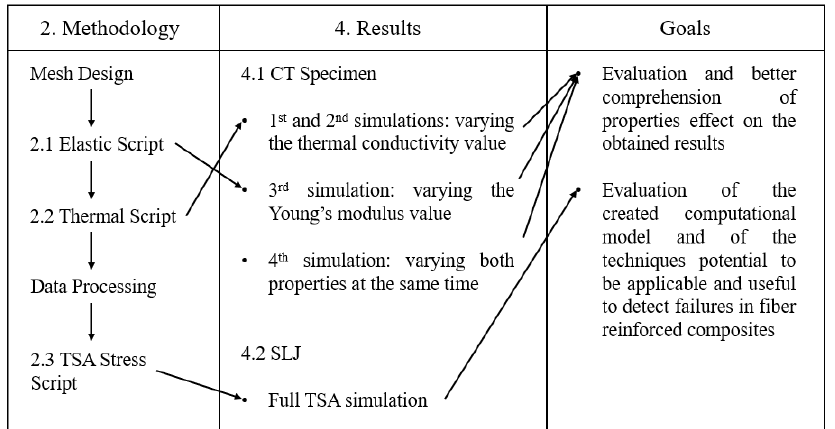
Figure 1. Workflow of this